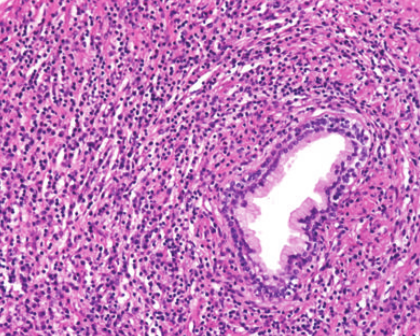
Figure 2: IgG4-related prostatitis. A prostatic gland is surrounded by a dense inflammatory infiltrate with numerous plasma cells. Prostatic vessels showed obliterative phlebitis (H&E, 200x).